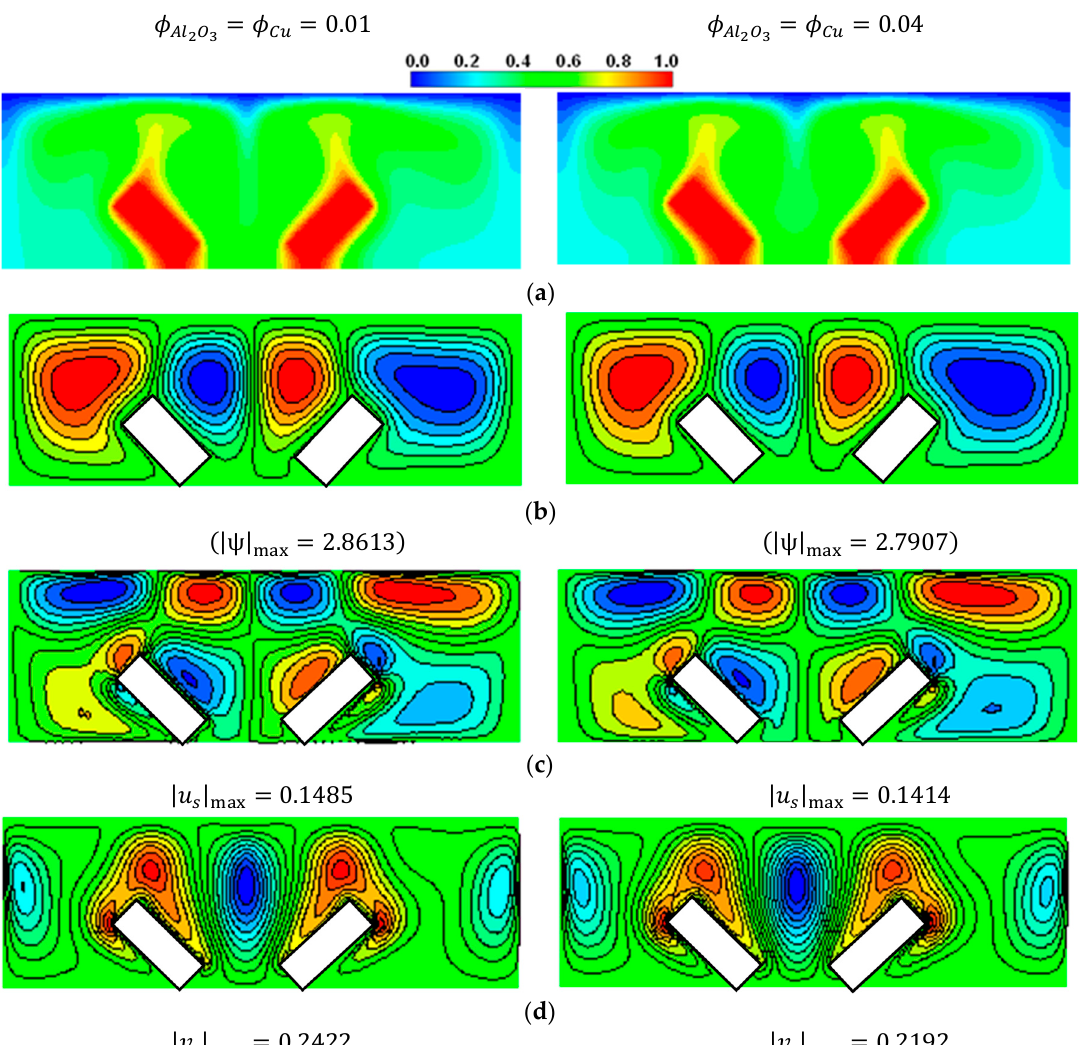
Figure 12. Effects of nanoparticle volume fraction for hybrid nanofluid on contours of ( a ) isothermal lines; ( b ) streamlines; ( c ) horizontal dusty velocity; ( d ) vertical velocity of dusty fluid at 𝐿 (cid:2869) = 𝐿 (cid:2870) = 0.5, 𝐷 (cid:3046) = 10, 𝛼 (cid:3046) = 0.01, 𝑅𝑎 = 10 (cid:2873) , 𝛾 (cid:2869) = 45 ° and 𝛾 = 0.1